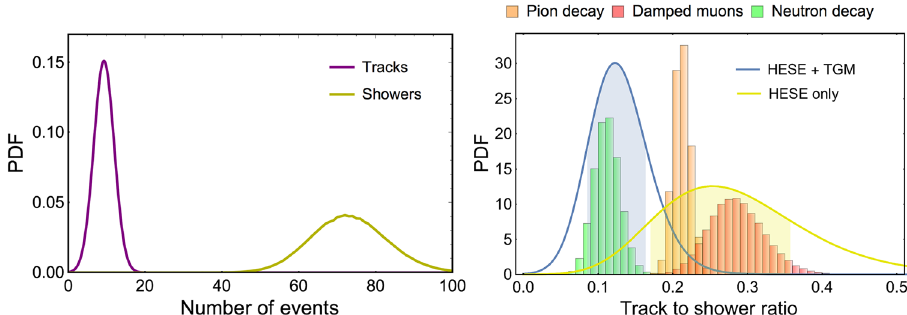
Fig. 4 On the left panel: likelihood for the number of astrophysical HESE tracks (purple curve) and astrophysical HESE showers (yellow curve) after 7.5 of exposure with IceCube. On the right panel: expected astrophysical track to shower ratio for different production mechanisms (orange bars for pion decay, red bars for damped muons, green bars for